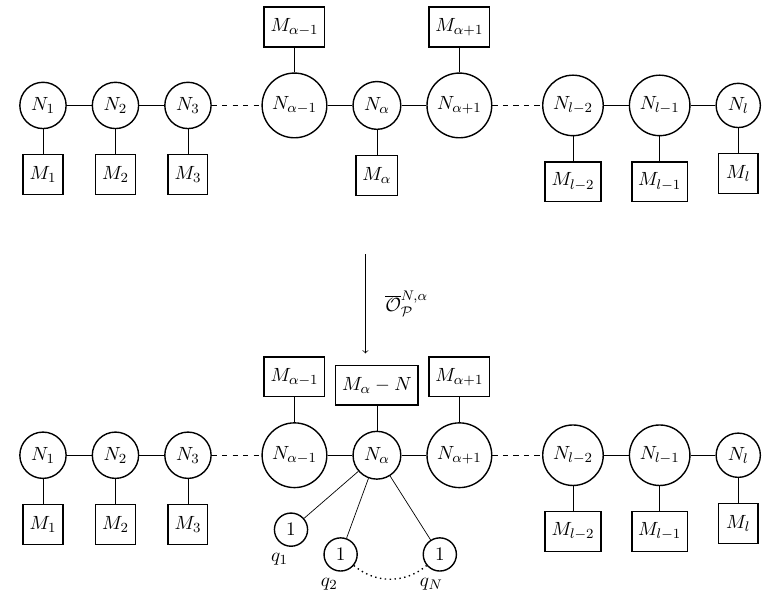
Figure 21 . Construction of the theory O N,α